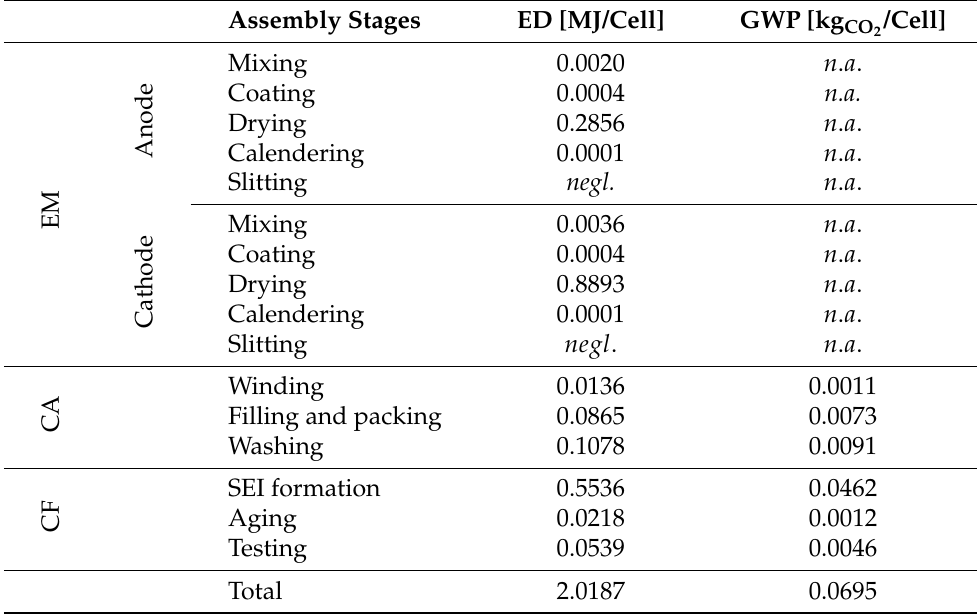
Table 6. Average ED and GWP related to the assembly stages of the